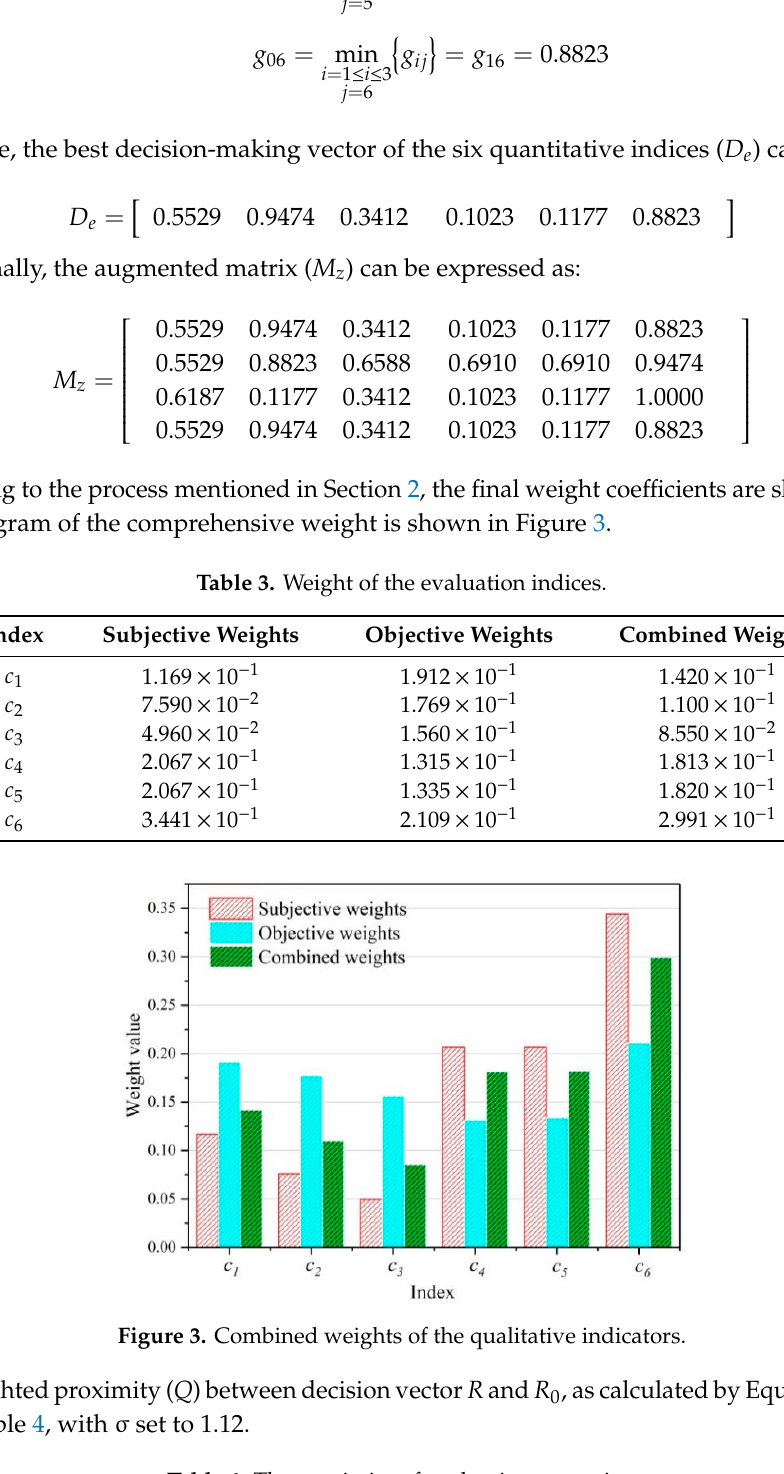
Table 4. The proximity of evaluation